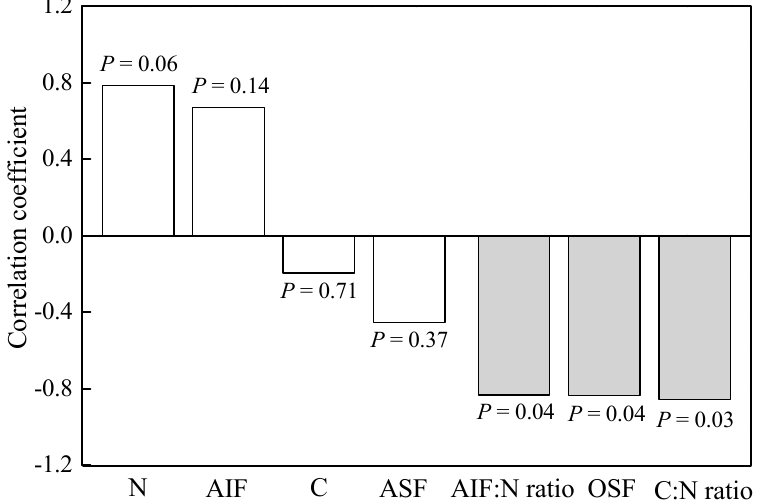
Figure 2. Correlation coefficients between initial chemical traits and root litter mass loss. Mass loss was measured from 50-µm mesh litterbags installed in unplanted pots (Figure 1b). Open and gray bars represent non-significant and significant results, respectively. OSF, organic soluble fraction; ASF, acid soluble fraction; AIF, acid insoluble fraction.